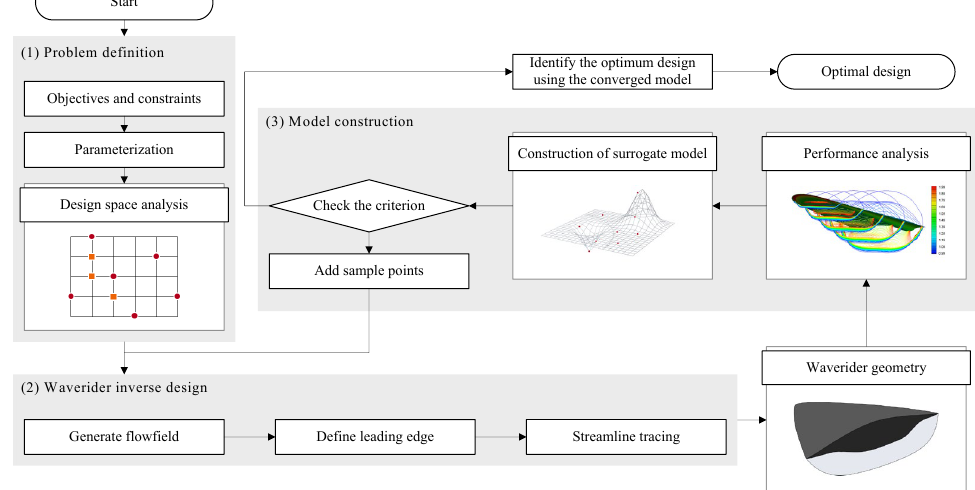
Figure 1. Direct optimization framework for waverider.